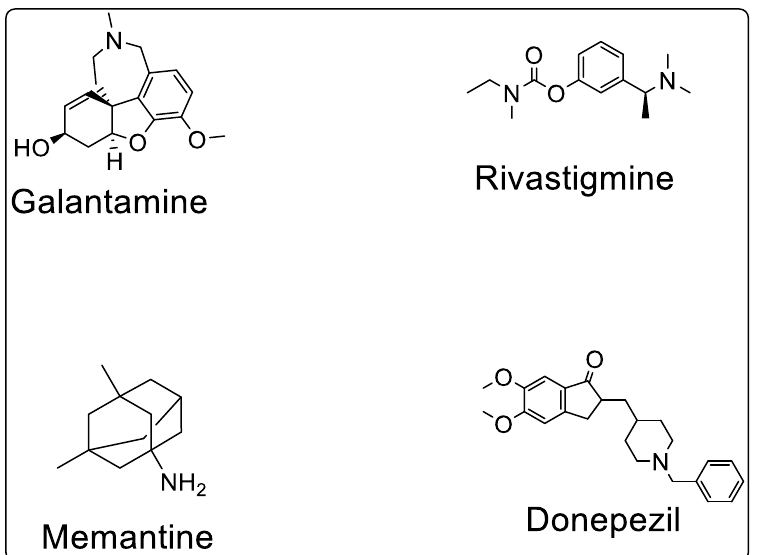
Figure 2. Chemical structures of FDA-approved anti-AD drugs.